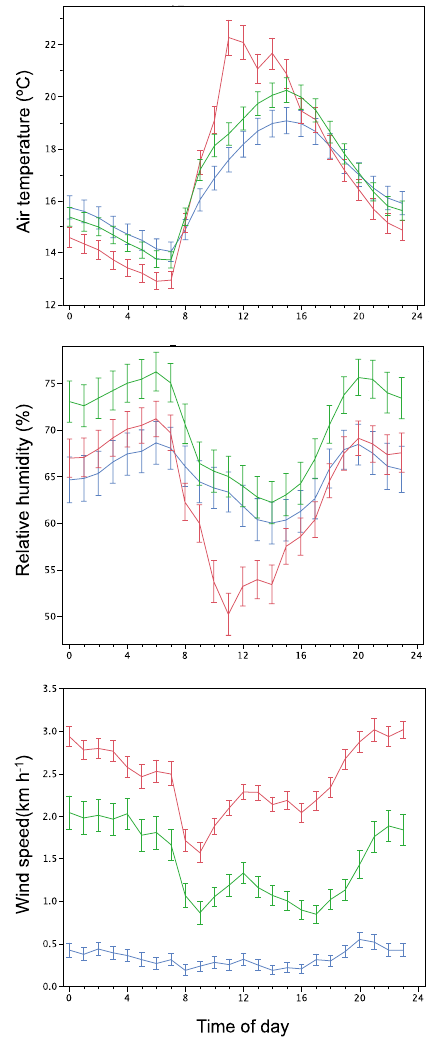
Figure 2. Mean ± standard error of hourly weather data in CL (blue), PP (red), and BA (green) stands during the selected 10-day sequence.